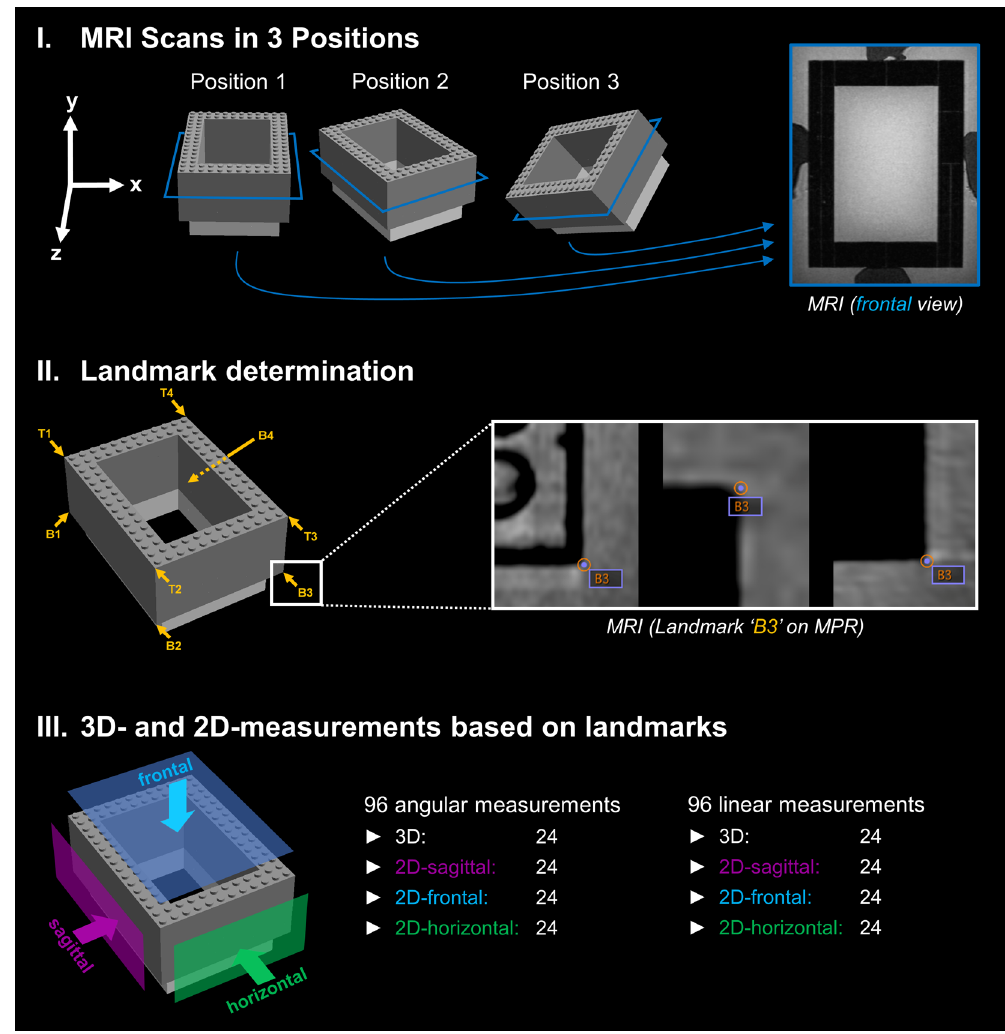
Figure 1. Workflow for analyzing the accuracy of the applied MRI technique. I For accuracy measurements, a cuboid-shaped Lego phantom (127.8 mm × 95.8 mm × 48.0 mm) was scanned on a 3 Tesla MRI system using a high-resolution 3D sequence. The phantom was placed in a plastic box filled with water and contrast agent before it was scanned in three positions (normal alignment, rotated, rotated and lifted). An exemplary MR image in frontal orientation (according to the blue section planes on the phantom graphics) is shown on the right side. II For each phantom position, the 4 vertices on the top (T1–T4) and the 4 vertices on the bottom (B1–B4) were determined as landmarks on multiplanar reconstructions (MPR) using DICOM Imaging Software (Osirix v.7.0.3). III Based on the landmarks’ coordinates, a total of 96 angles and 96 distances were calculated for each phantom position using a customized software